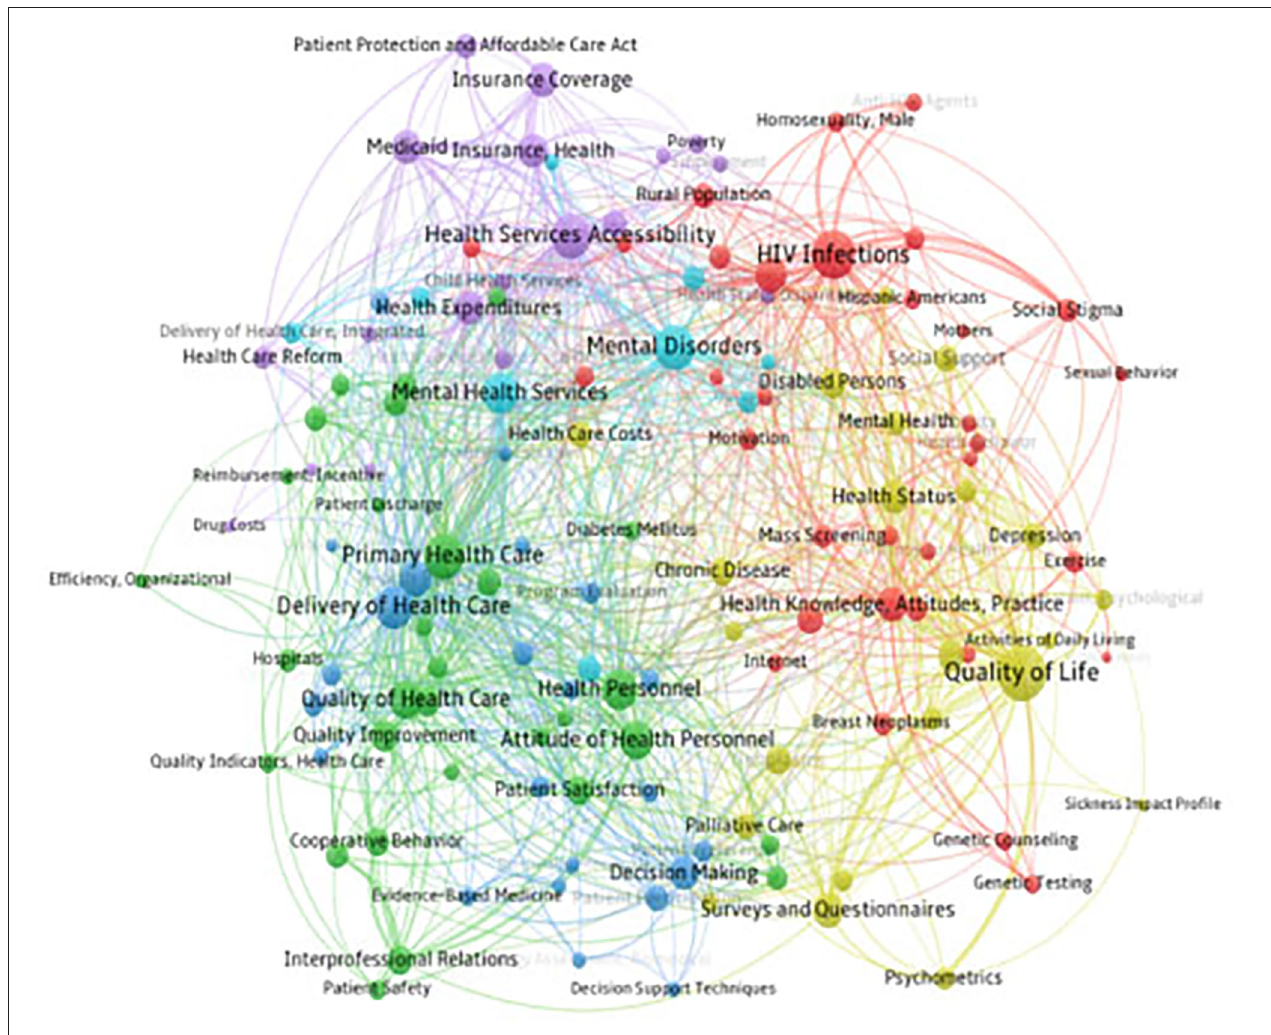
FIGURE 4 | Research topics about health policy and services from 2016 to